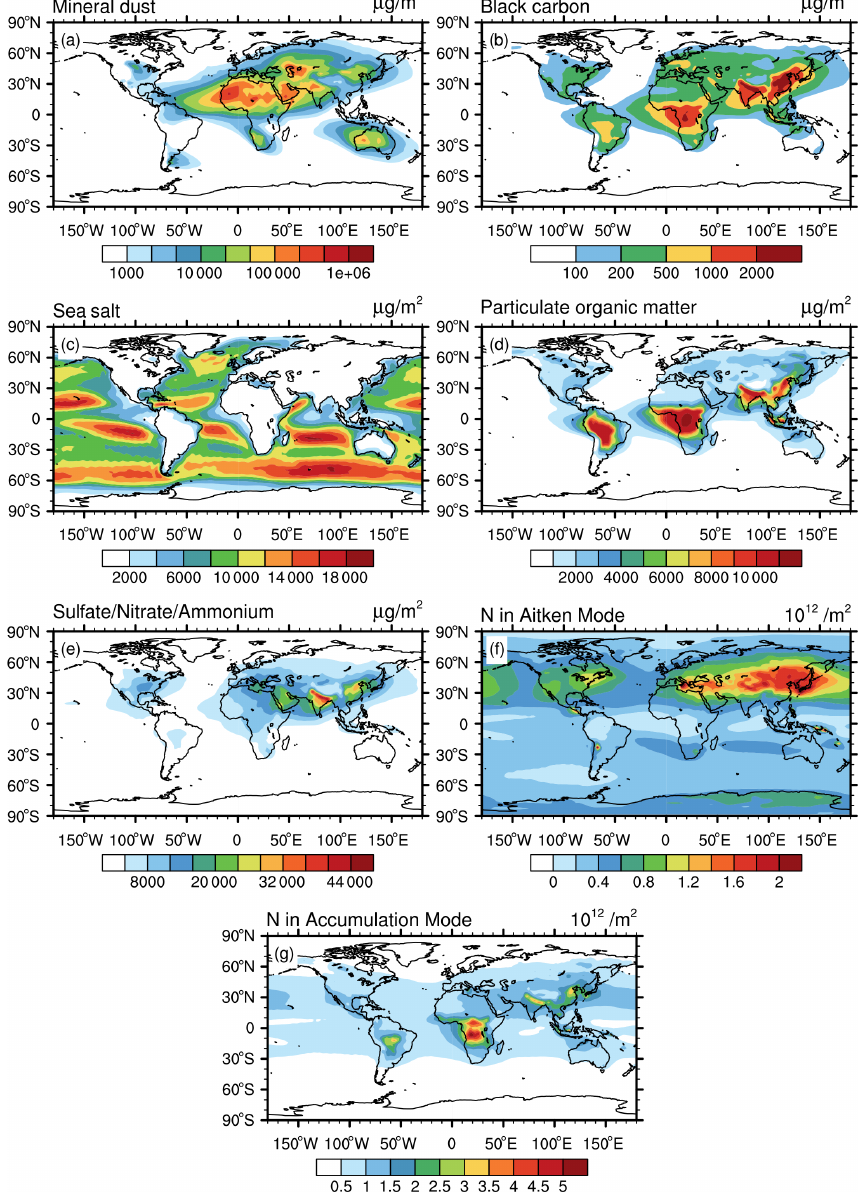
Figure 1. Simulated climatological aerosol properties for the lower troposphere (surface to ∼ 700hPa), including vertically integrated mass concentration of mineral dust (a) , BC (b) , sea salt (c) , POM (d) , and SNA (e) and the vertically integrated particle number concentration of the Aitken mode N akn (f) and accumulation mode N acc (g)